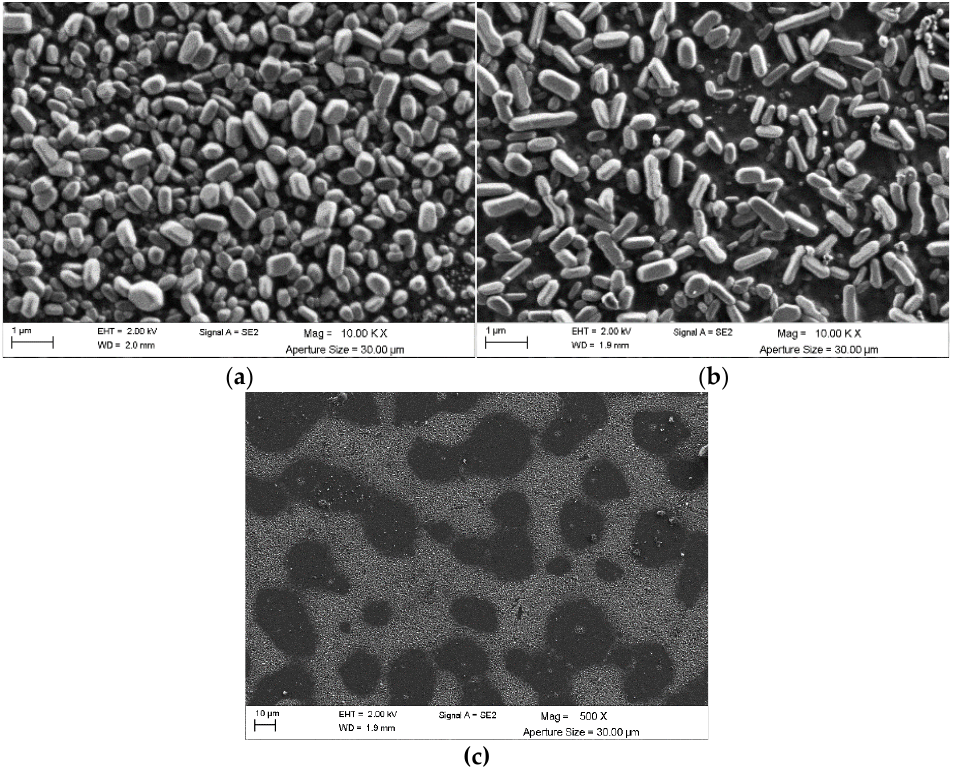
Figure 5. SEM micrographs of LuVO 4 : 2.5% at. Eu 3+ , 1.5% at. Bi 3+ films films: ( a ) after annealing for 3 h at 700°C, 10,000 × , ( b ) after annealing at 1000°C for 3 h, 10,000 × , and ( c ) after annealing at 1000°C for 3 h, 500 × .